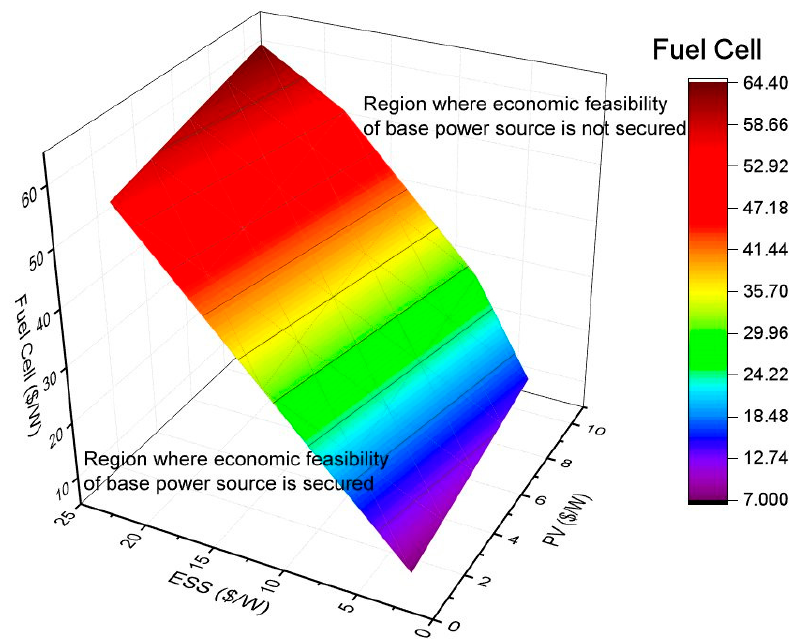
Figure 7. Visualization of the criterion under which a system with base power source is economical.